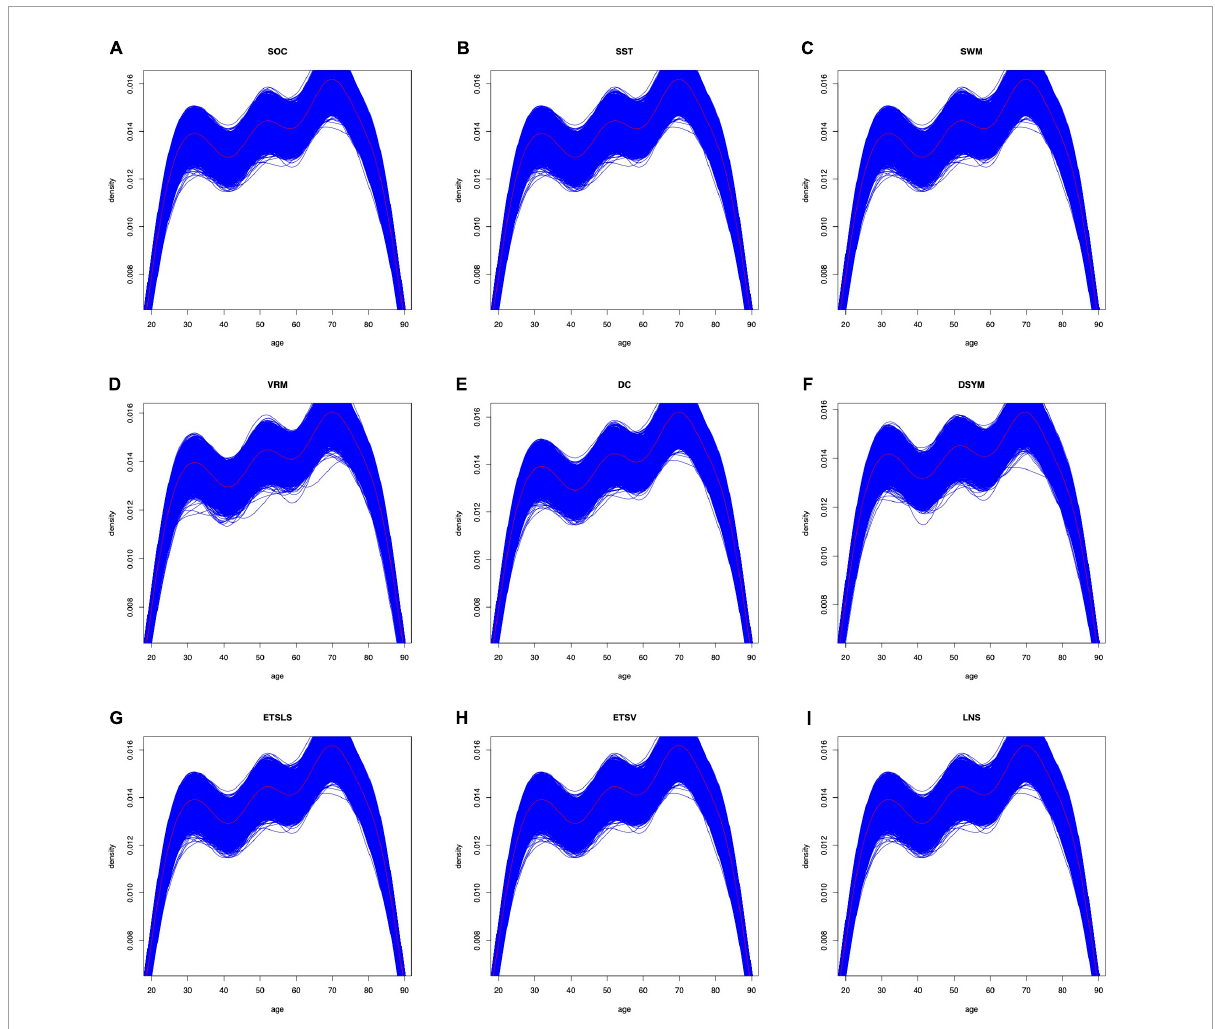
FIGURE9 Age distributions for the training models in each task. (A–I) Denote the nine cognitive tasks. The blue curves fit the distributions of age in each training folds. The black curves fit the distributions of age for all samples in each